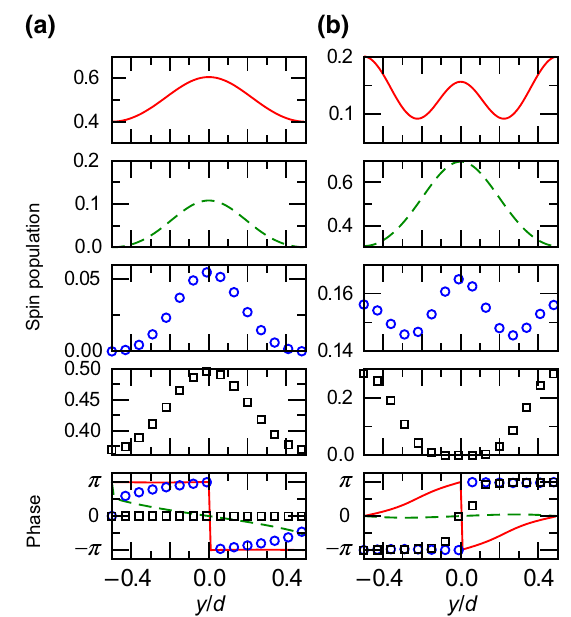
FIG. 6. Spin population and phase versus y for case 2 (see the text). Calculations are performed for a BEC at q y = 0 in the (a) ground band and (b) first excited band. The red line, green dashed line, blue circles, and black squares correspond to | 1 (cid:2) , | 2 (cid:2) , | 3 (cid:2) , and | 4 (cid:2) ,